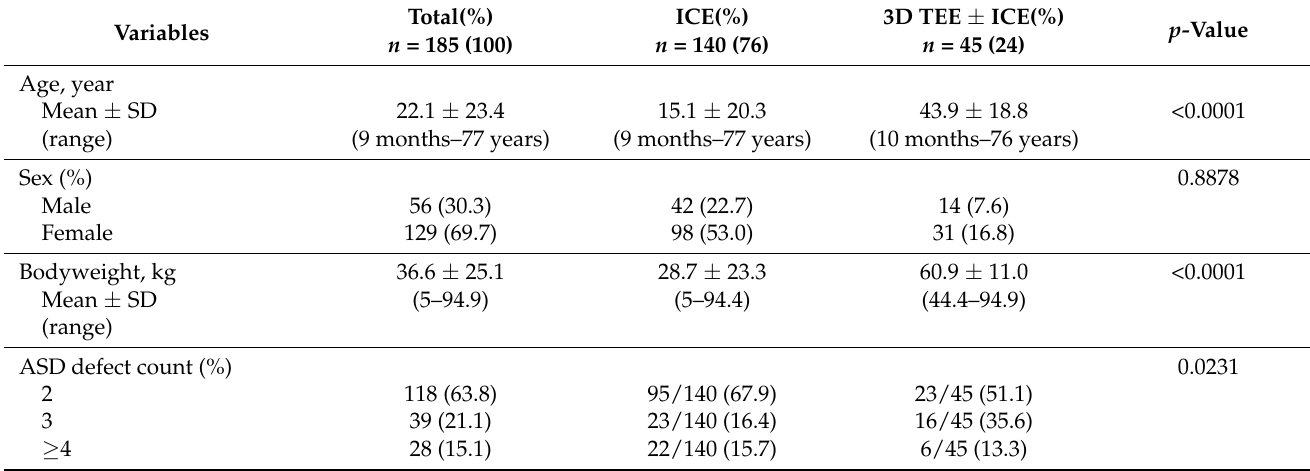
Table 1. Patients’ baseline and pre-procedural